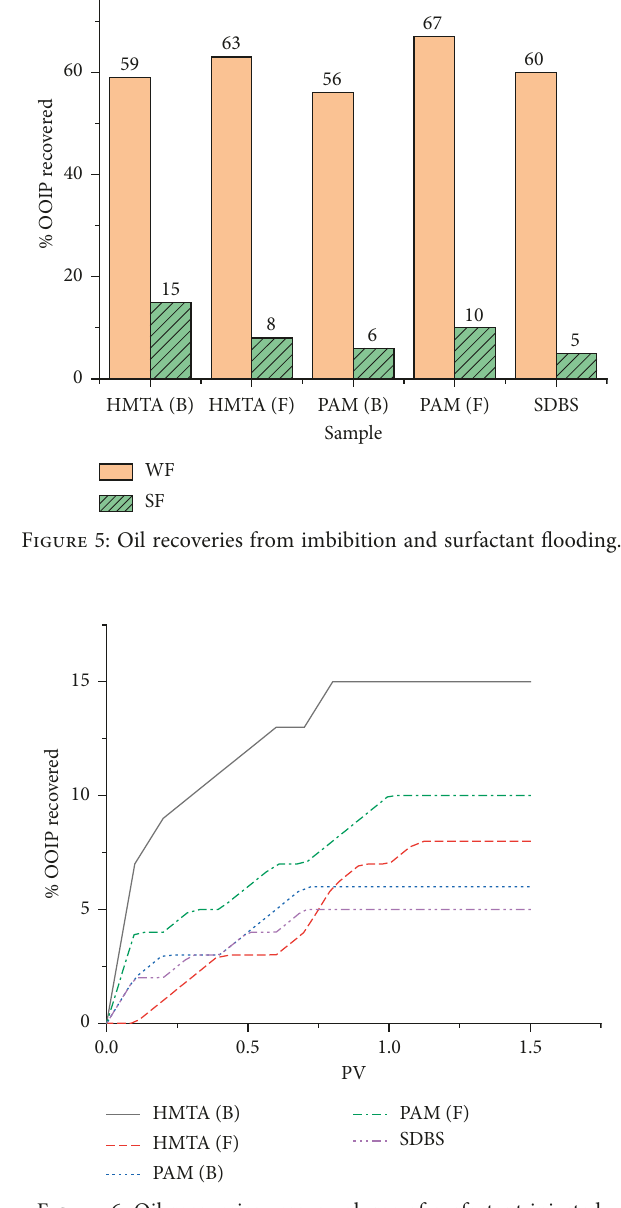
Table 2: IFT of the surfactant blends from lab measurement. Sample